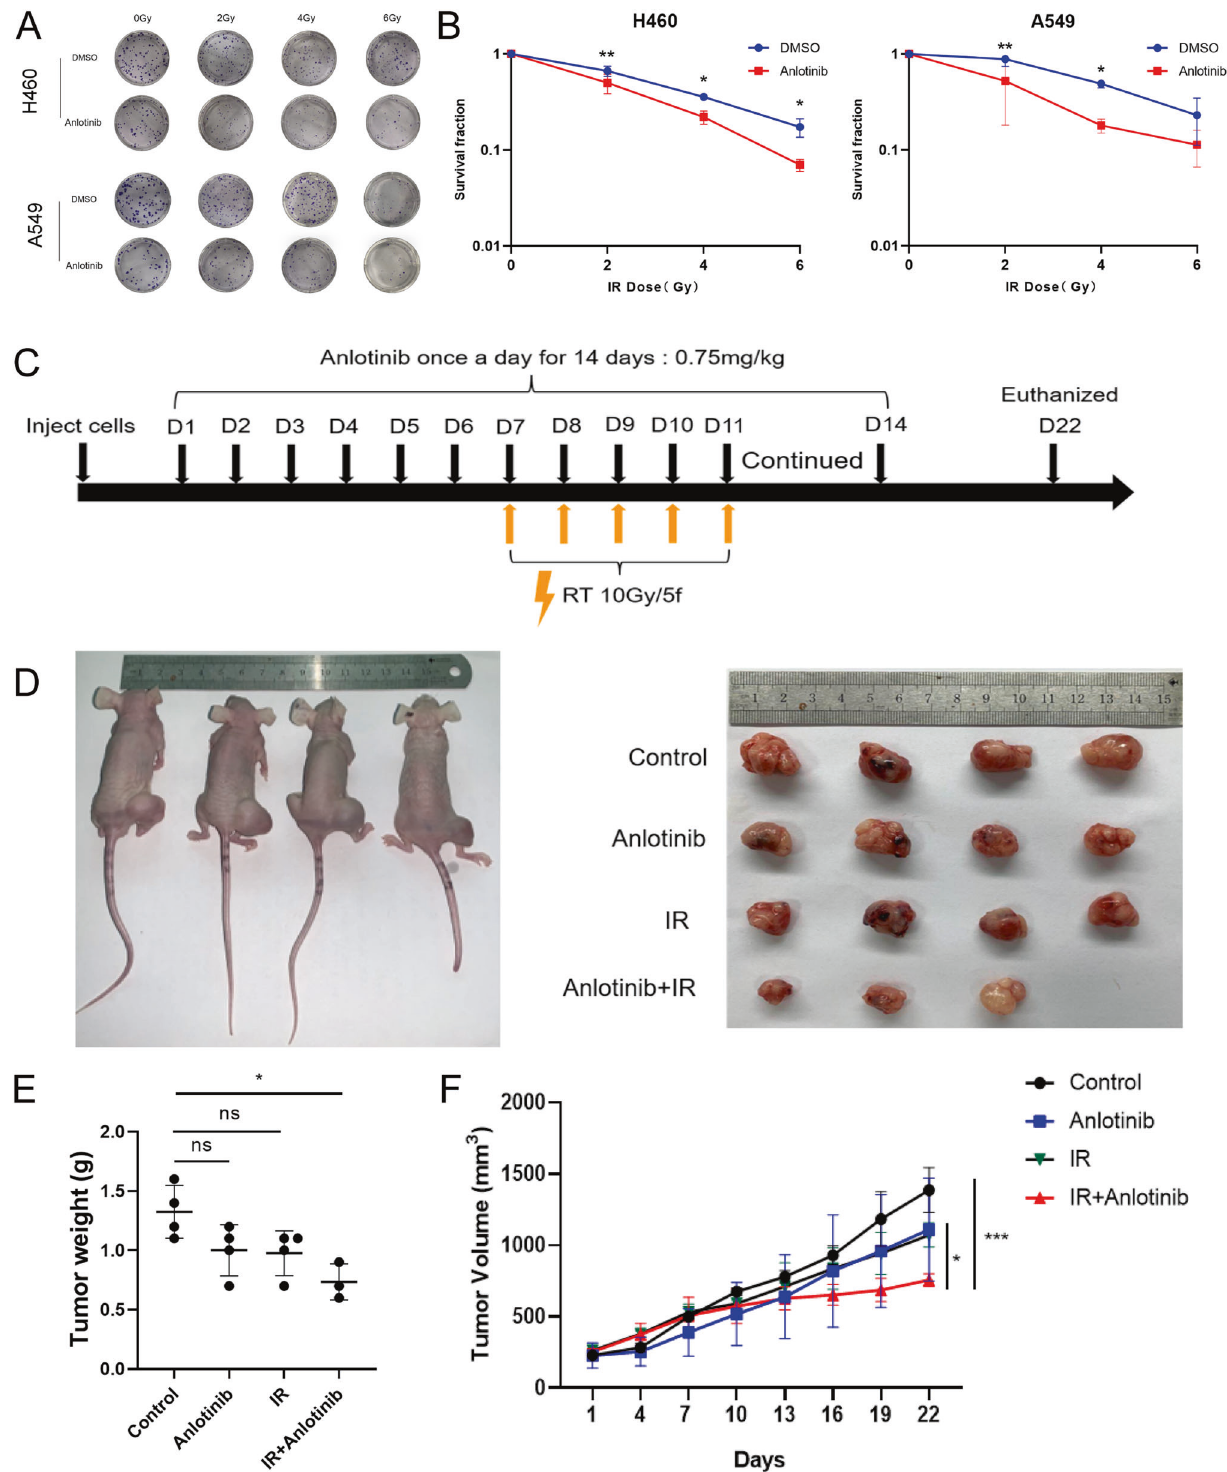
Fig. 1 Anlotinib enhances radiosensitivity of NSCLC in vitro and in vivo. A Representative images of colony formation of H460 and A549 cells irradiated with 0, 2, 4 and 6 Gy. B The cell survival curves were fi tted with the linear-quadratic model. C When the tumor grew to a volume of approximately 200 mm 3 , mice were randomly divided into the following four groups: control ( n = 4), anlotinib ( n = 4), IR ( n = 4), and IR plus anlotinib ( n = 3). Experimental schedule of anlotinib and IR combination treatment for H460 tumor-bearing mice. D – F Tumor weight and volume of xenografts were shown in the graphs. One-way ANOVA with Tukey ’ s multiple comparison was performed for tumor weight comparison and two-way ANOVA with Tukey ’ s multiple comparison was conducted for tumor volume analysis with GraphPad Prism 8.0.2. Data are presented as the mean ± standard deviation, ns = not signi fi cant, * p < 0.05, ** p < 0.01, *** p < 0.001.